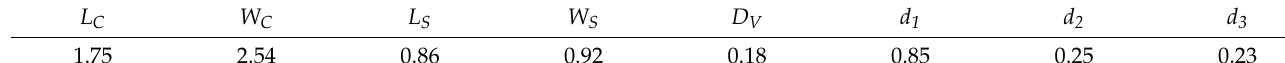
Figure 4. S-parameters comparison between classical filter synthesis and full-wave electromagnetic simulation of the proposed single transition. Table 1. Dimension parameters of the proposed transition (unit: mm).